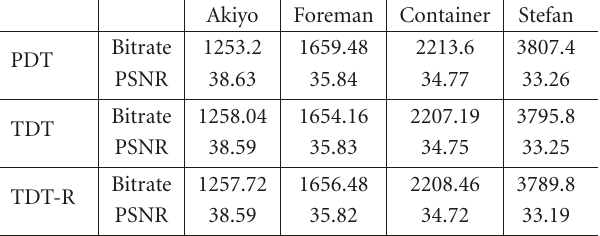
Table 2: RD performance comparisons with QP = 30. Bitrate: kbps, PSNR: dB.